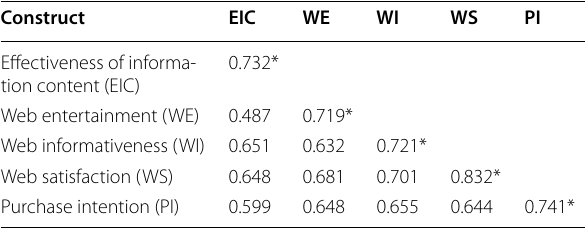
* Implies the squared root of the AVE; others are correlation coefficients